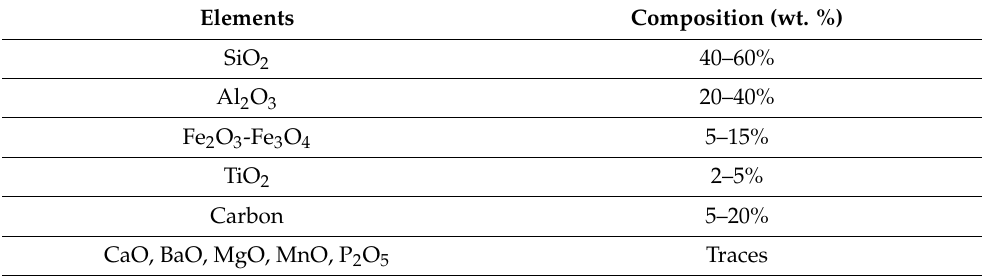
Table 1. Elemental composition of fly